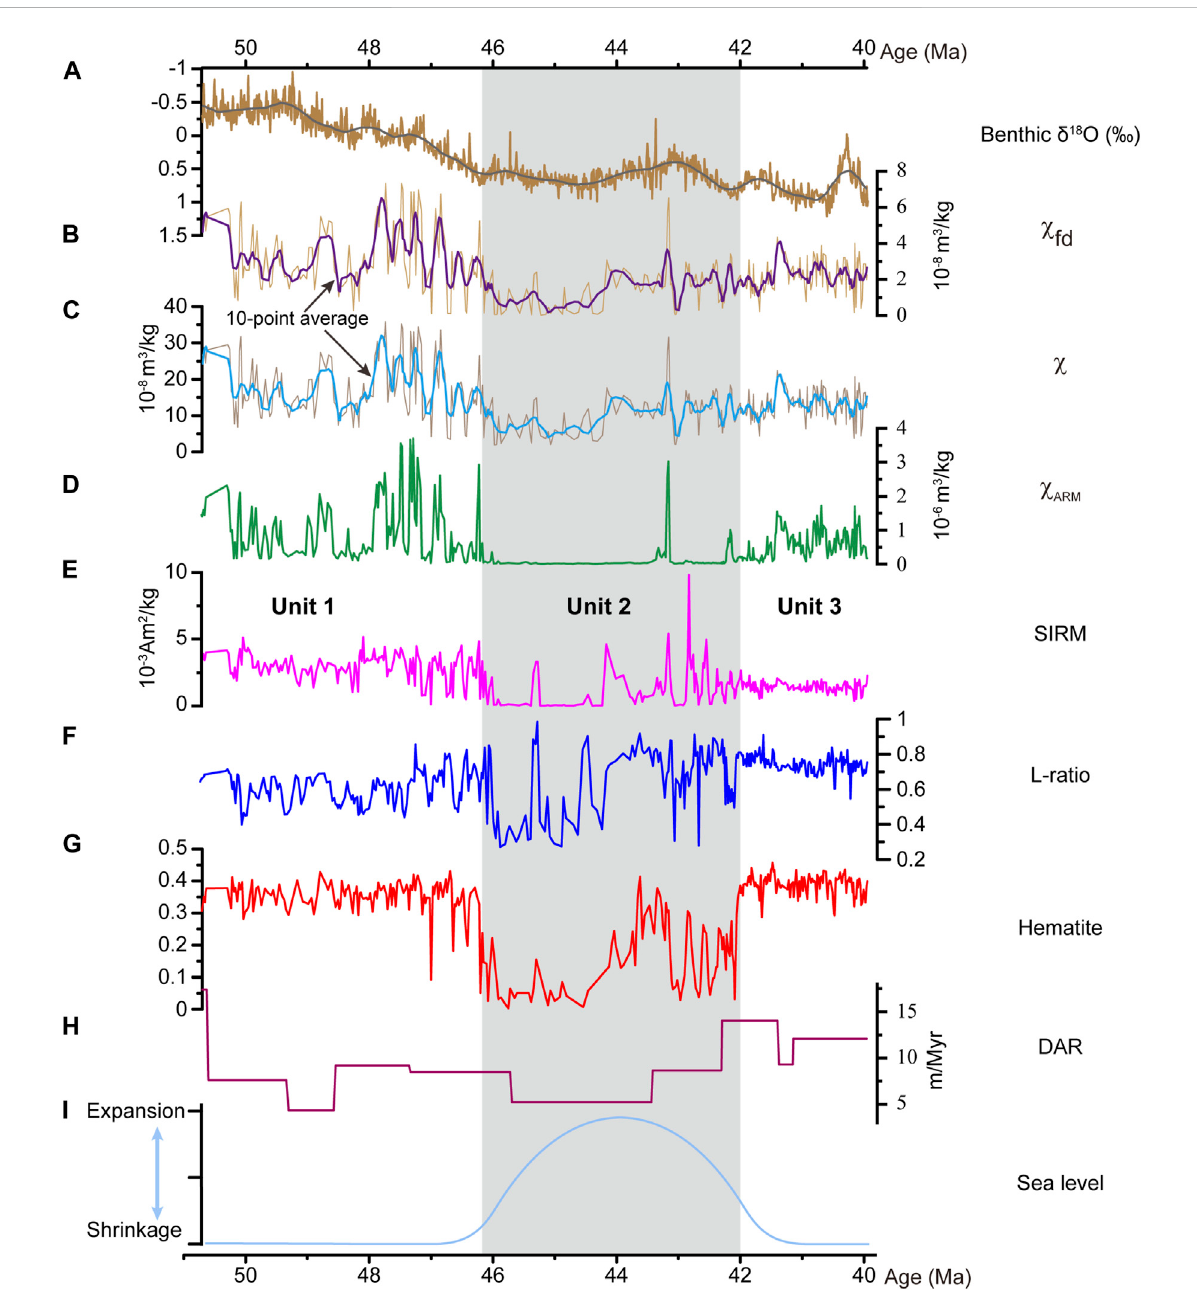
FIGURE 2 Xishuigou environmental magnetic records compared with other Paleogene climatic records. (A) Benthic oxygen isotope stack (Westerhold et al., 2020). (B – H) χ fd , χ , χ ARM , SIRM, L-ratio, the hematite content, and dust accumulation rate (DAR) records from the Xishuigou section. (I) The Paratethys sea level variations in the Tarim region (Bosboom et al.,